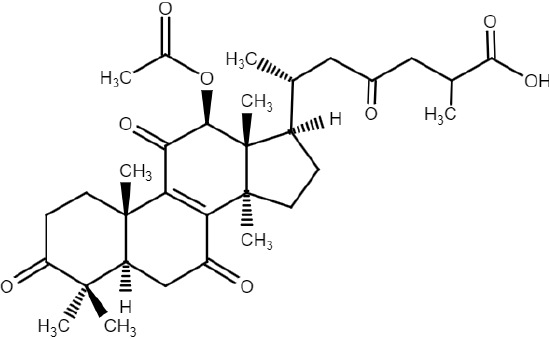
Figure 1. The chemical structure of ganoderic acid F (GAF).